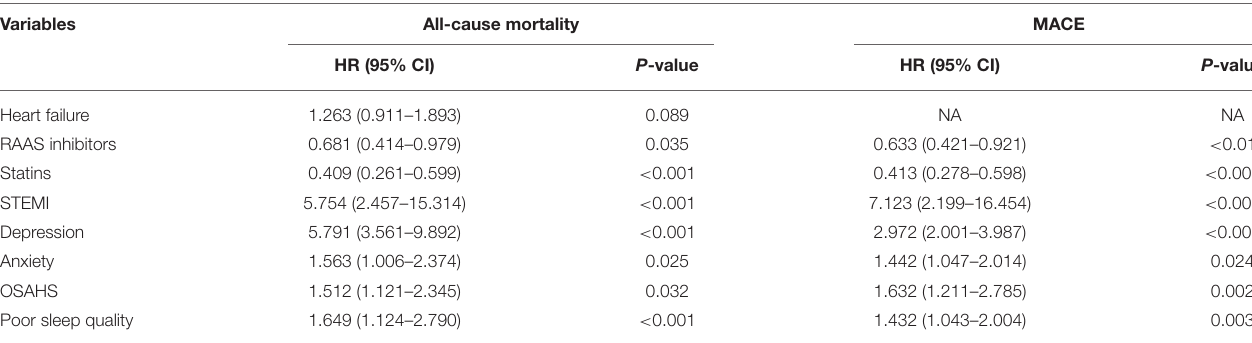
TABLE 5 | Multivariate Cox regression of variables influencing all-cause mortality and MACE.